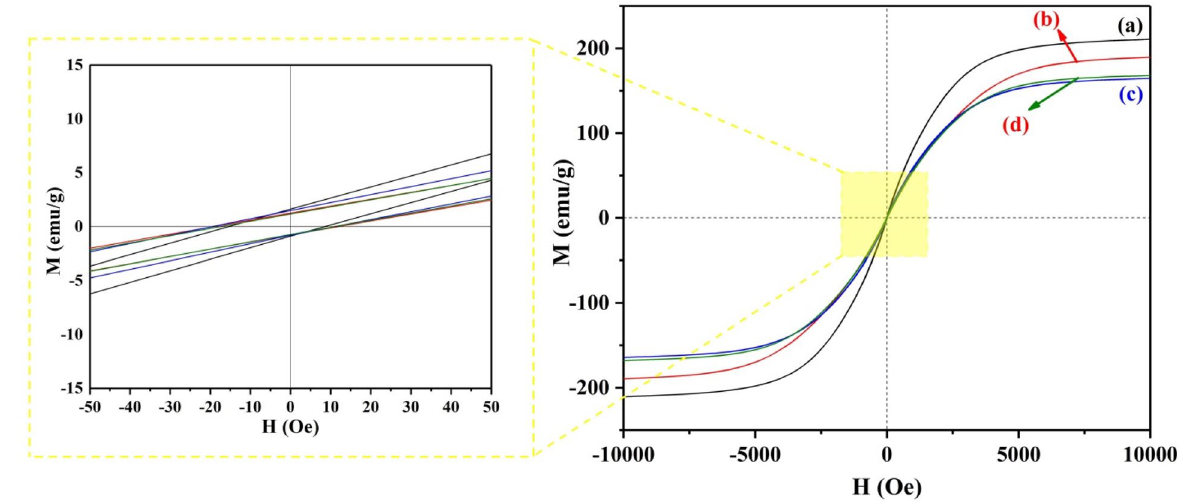
Figure 4. VSM curve for modified hydrophobic particles ( a ) bare CI, ( b ) SiO 2 , ( c ) SiO 2 @FAS, and ( d ) SiO 2 @ HDMS. Sample